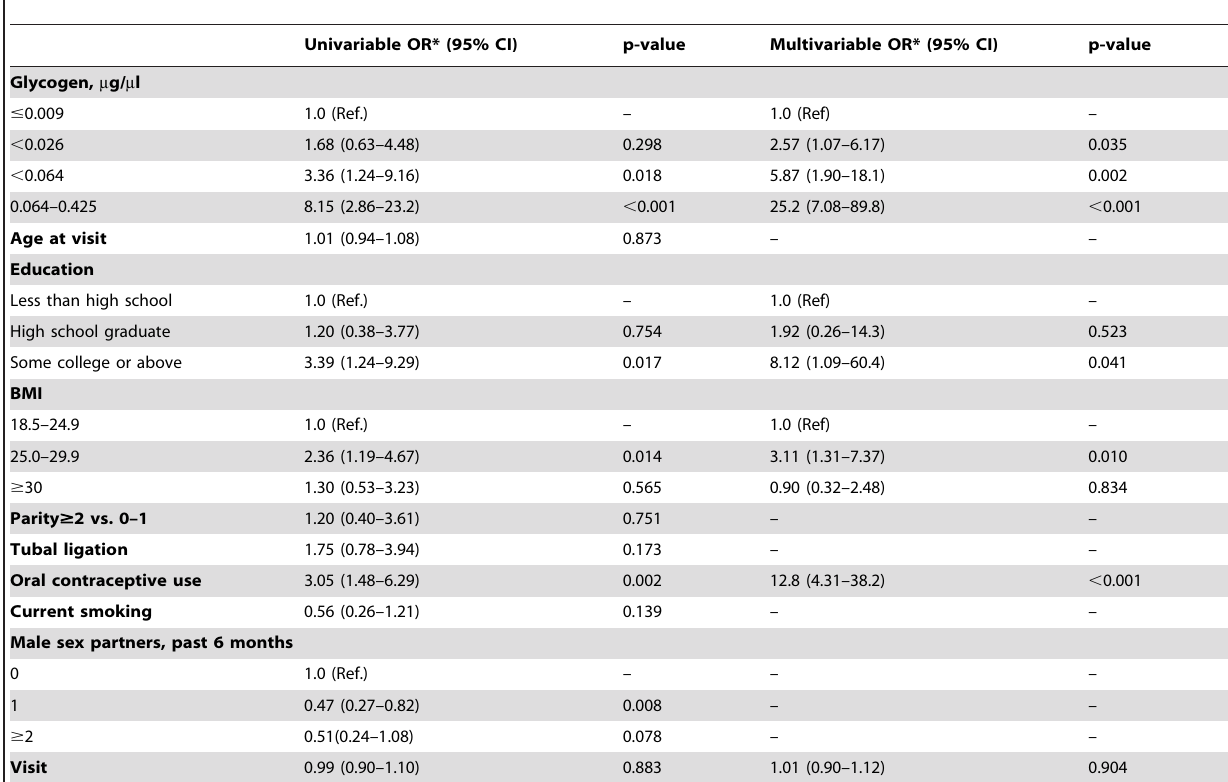
Table 3. Factors Associated with Lactobacillus $ 85%, N=177